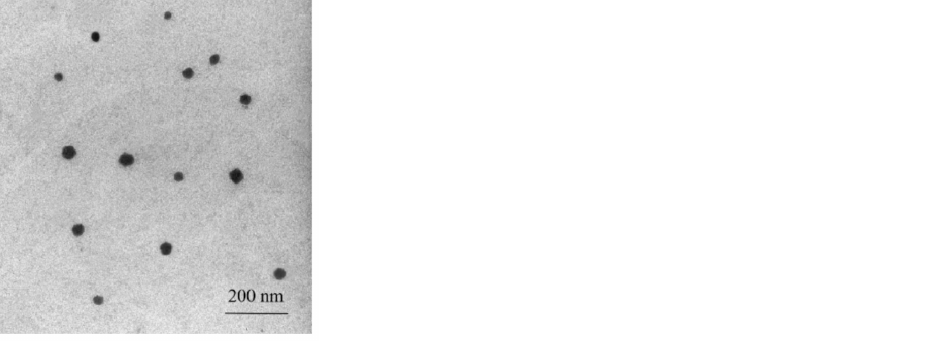
Figure 2. The particles of the Massoia lactone-loaded NEs observed under transmission electron